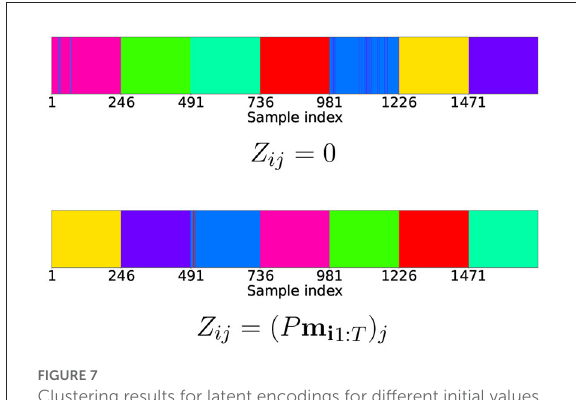
FIGURE7 Clustering results for latent encodings for different initial values of Z . All 1715 samples are presented in order of consecutive 245-element batches, in which every batch is a collection of motions belonging to the same primitive. The coefficient τ is set in such a way, that in both cases, the coefficient of determination R 2 0.9999. This means resulting manifolds are = very close to affine.